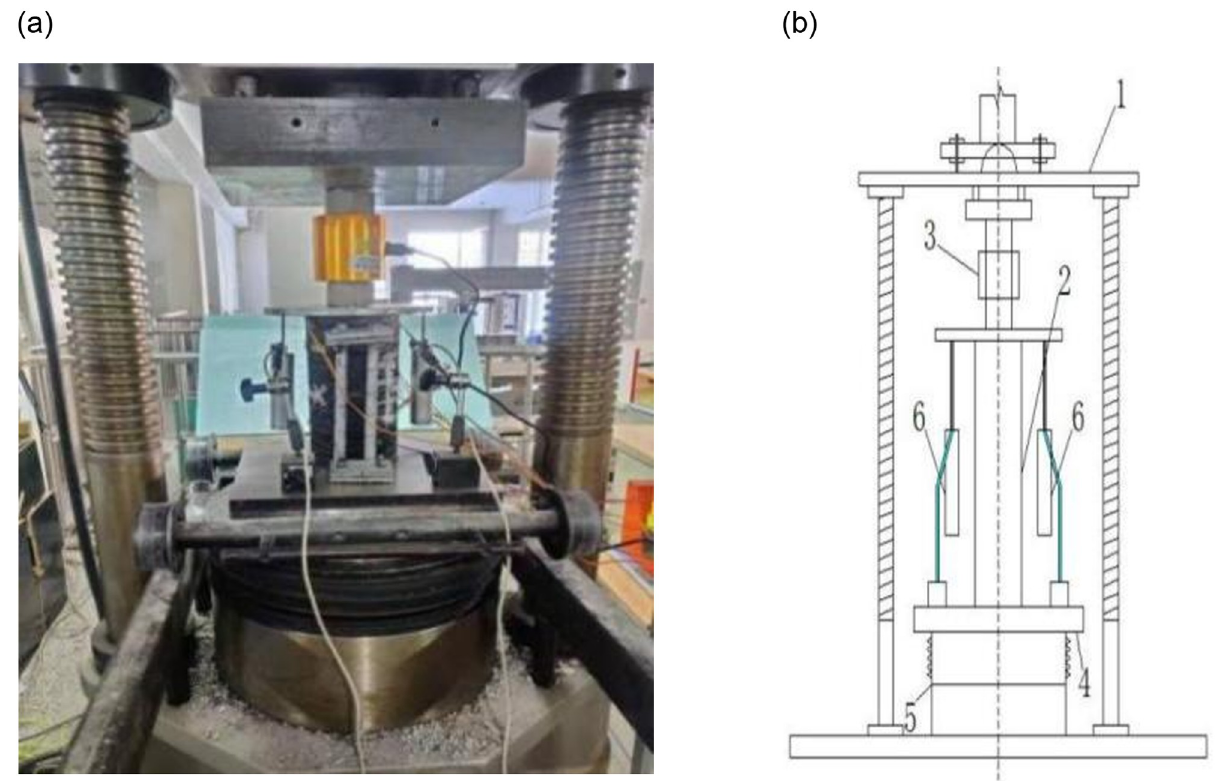
Fig 4. Test device. 1-Upper pressing plate of testing machine. 2-Testing column. 3-Load sensor. 4-Lower pressing plate of testing machine. 5-Testing machine cylinder. 6-Displacement sensor.